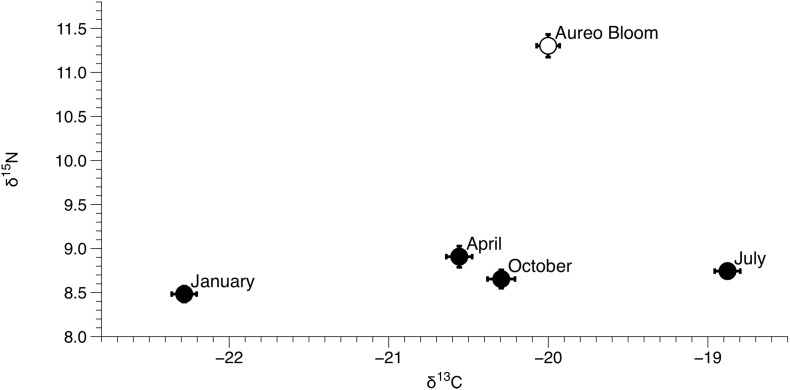
Mean (±SE) δ15N and δ13C values of Amphibalanus eburneus for each season from January to October of 2015 and during an Aureoumbra lagunensis bloom in January 2016.Values were calculated from δ15N and δ13C values of Amphibalanus eburneus from all sites within the three sublagoons of the Northern Indian River Lagoon.